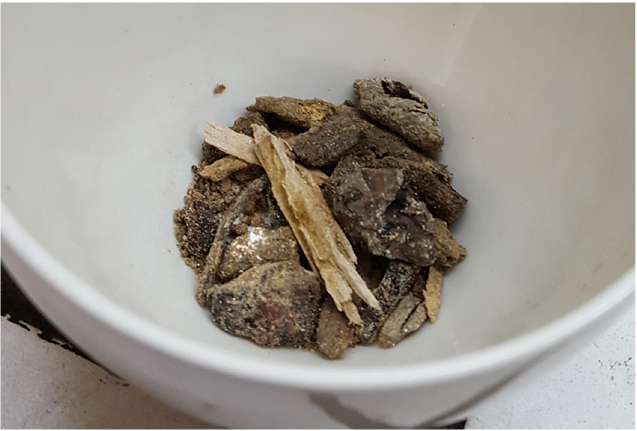
Figure 3. Example of contaminants found in a random sample of CDRA.